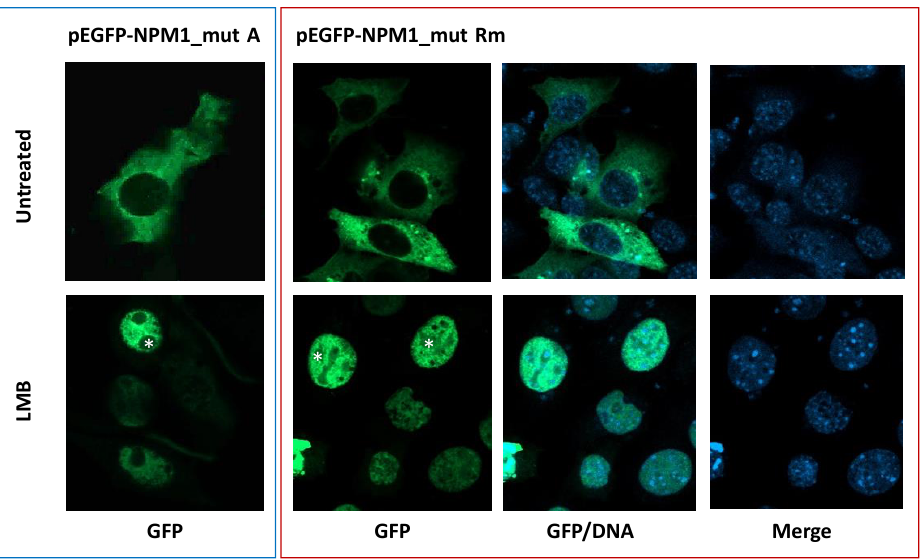
Figure 5. The subcellular localization of the new NPM1 mutant Rm is NES-dependent. NIH-3T3 overexpressing either the GFP-NPM1 mutant A or the new GFP-NPM1 mutant Rm fusion proteins. Untreated: vehicle. LMB: leptomycin B. GFP: green fluorescence protein (of the GFP-NPM1 fusion protein). DNA: indicates stained nuclei (blue). Images were acquired using a Zeiss LSM 800 confocal microscope (Carl Zeiss) with a 488-nm (for eGFP) laser line for excitation, and a 63×/1.4 OIL Plan-